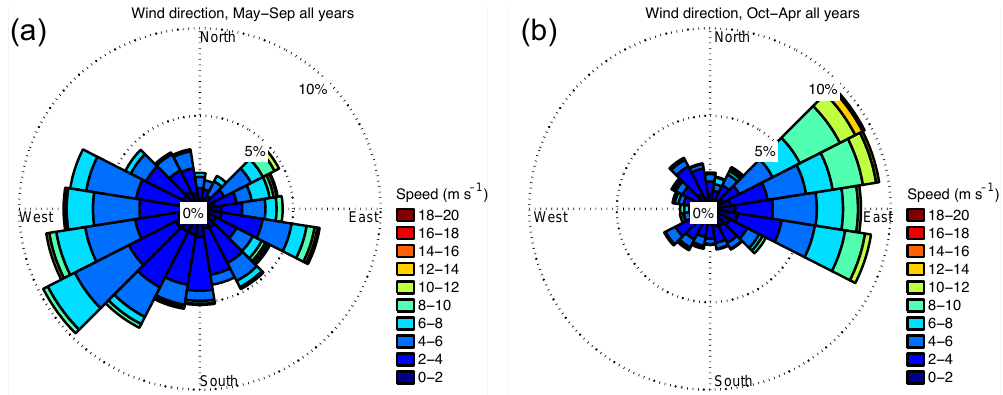
Figure 4. Wind roses for the tower averaged over (a) May–September and (b) October–April for all 3 years during midafternoon hours, from the 2-D sonic anemometer at the 32ma.g.l. level of the tower.